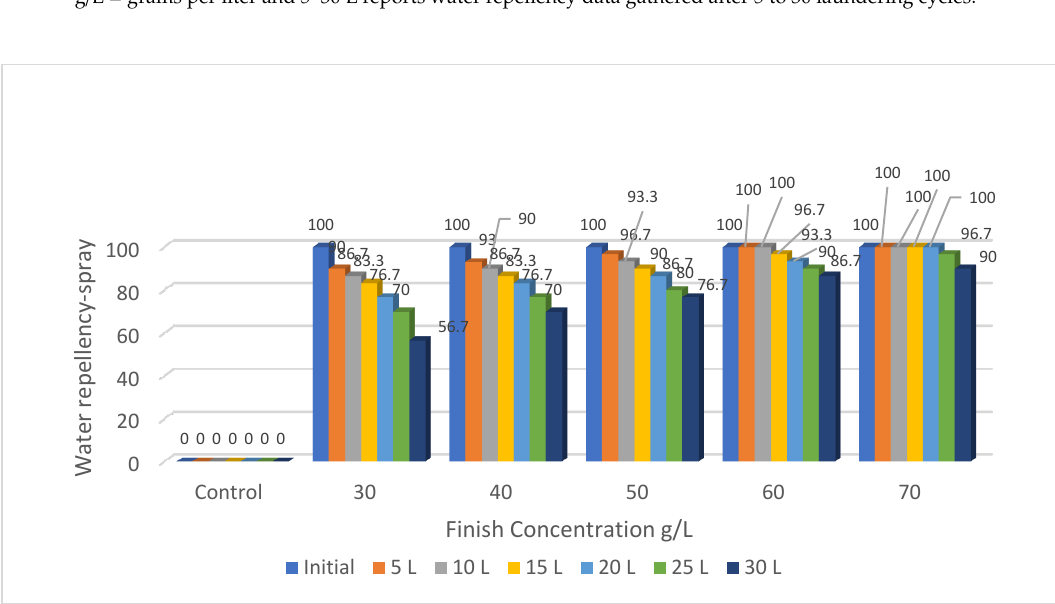
Figure 2. Effect of laundering on water-repellency (spray test) of polyester/cotton. Figure 2. E ff ect of laundering on water-repellency (spray test) of polyester /